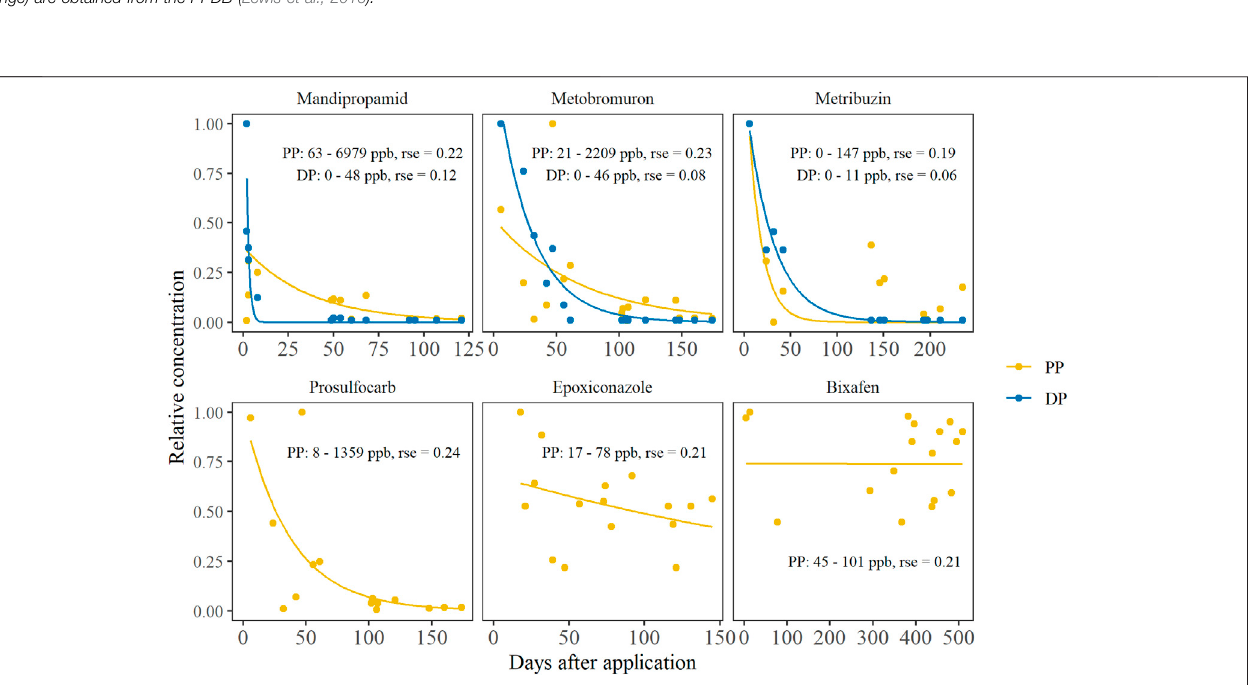
Frontiers in Environmental Science |